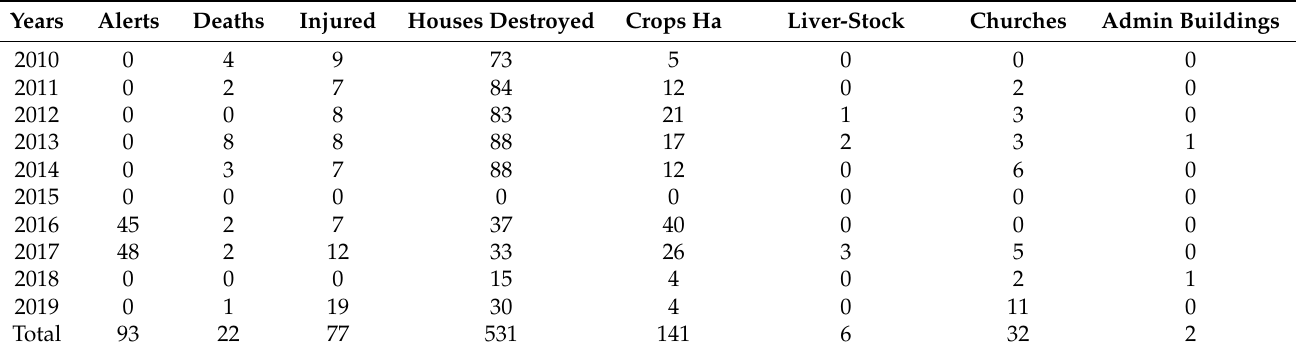
Table 3. Summary of the fire incidents recorded over the past 10